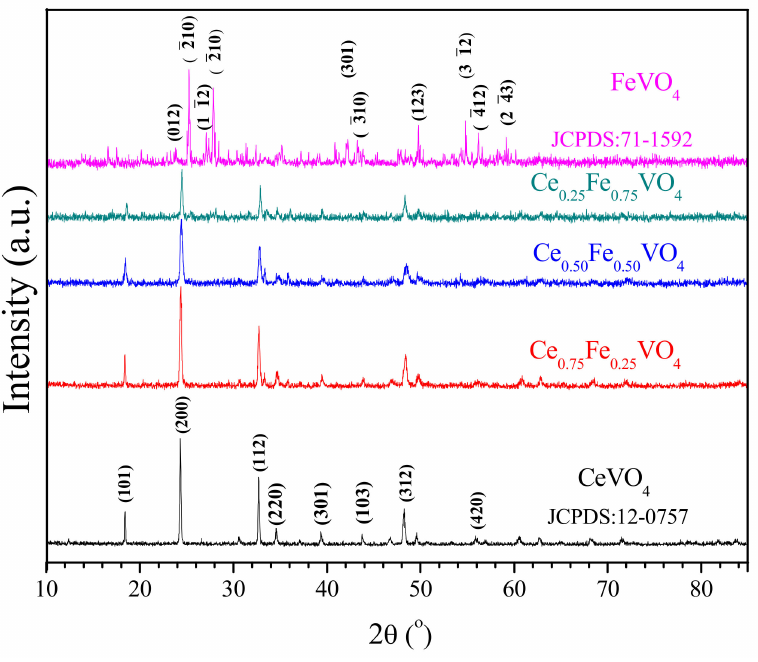
Figure 2. XRD patterns of Ce 1 − x Fe x VO 4